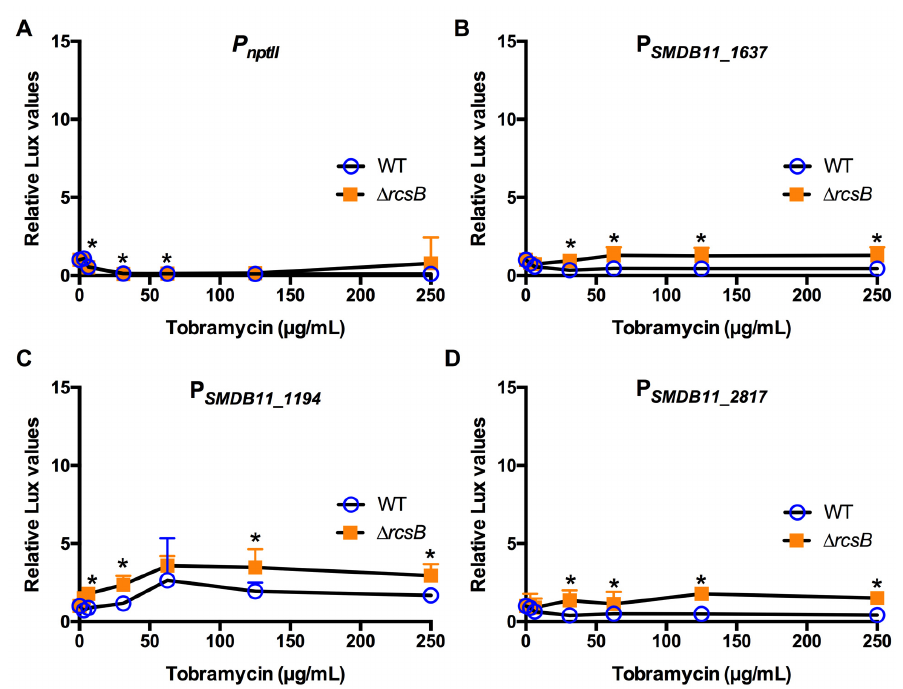
Figure 8. Effect of protein synthesis-targeting antibiotic tobramycin on Rcs-activated promoters ( A – D ). Relative luminescence values were determined by dividing luminescence by optical density after 4 h of antibiotic challenge. The nptII promoter ( A ) was unaffected by tobramycin. The experimental promoters were expressed to equal or greater extent in the ∆ rcsB mutant than the WT. Mean and standard deviation are shown ( n = 6–9 are shown). Asterisks (*) indicate statistical differences between groups at the indicated concentrations, p < 0.05.